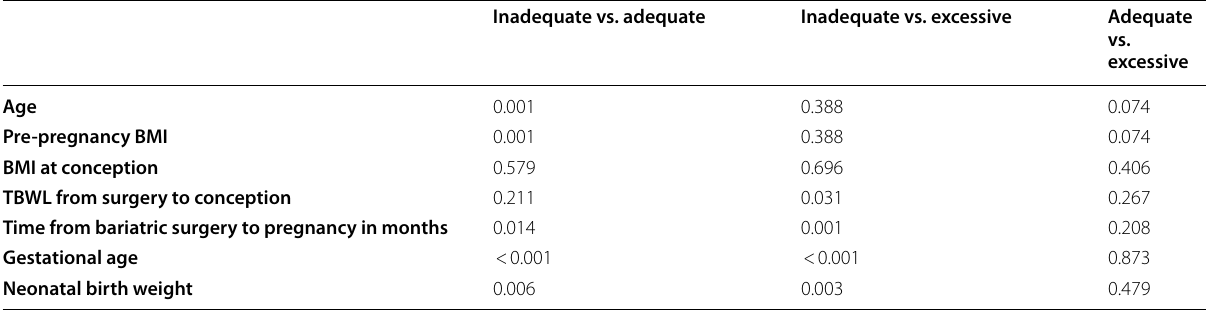
Table 5 Post‑hoc test using Dunn’s multiple comparison, to indicate which groups were significantly different from each other Inadequate vs.